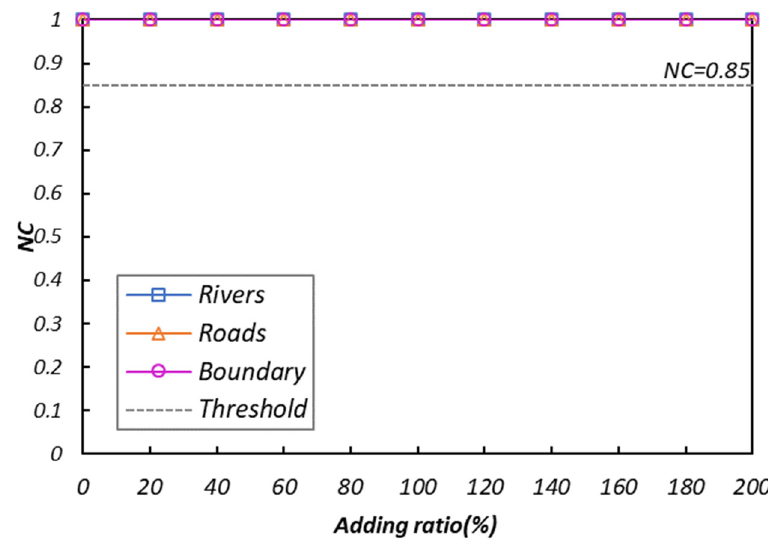
Figure 10. The results of vertex addition attacks.